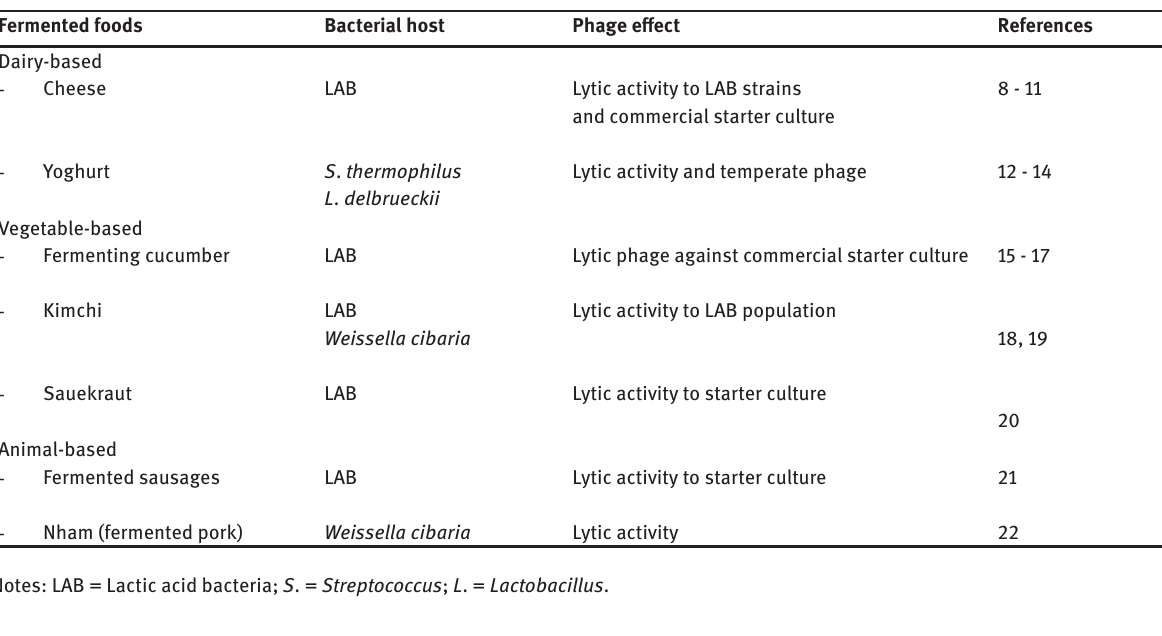
Table 1: Fermented food products and their associated bacteriophages.